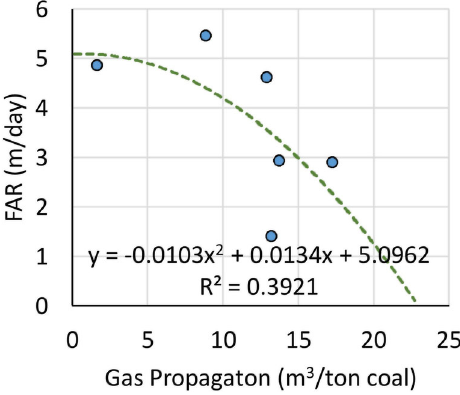
Fig. 9 Relationship between gas propagation and FAR, an exponen- tial regression analysis